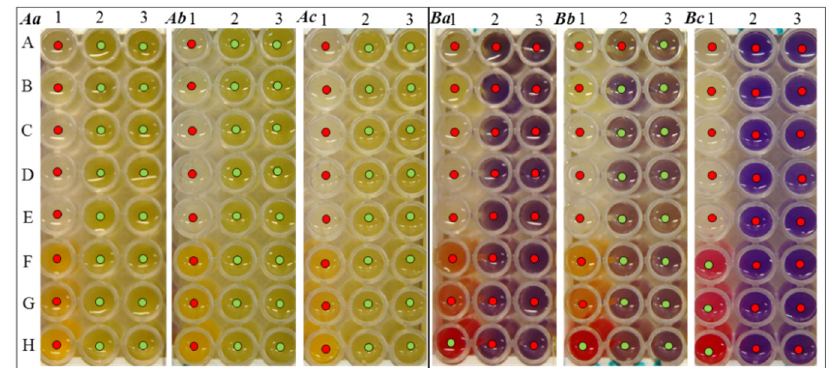
Figure 3. Biochemical properties of tested G + bacterial strains ( A ) S. aureus , and/or ( B ) MRSA. ( a ) without UV exposure, ( b ) after exposure to laboratory UV and ( c ) after stratospheric UV radiation. Biochemical changes were observed by biochemical markers after 24 hours of incubation in a thermostat at 37 °C. Legend: 1A, aesculin; 1B, phosphatase; 1C, β -glucosidase; 1D, β -glucuronidase; 1E, β galactosidase; 1F, ornithine; 1G, arginine; 1H, urease; 2A, mannose; 2B, xylose; 2C, maltose; 2D, mannite; 2E,